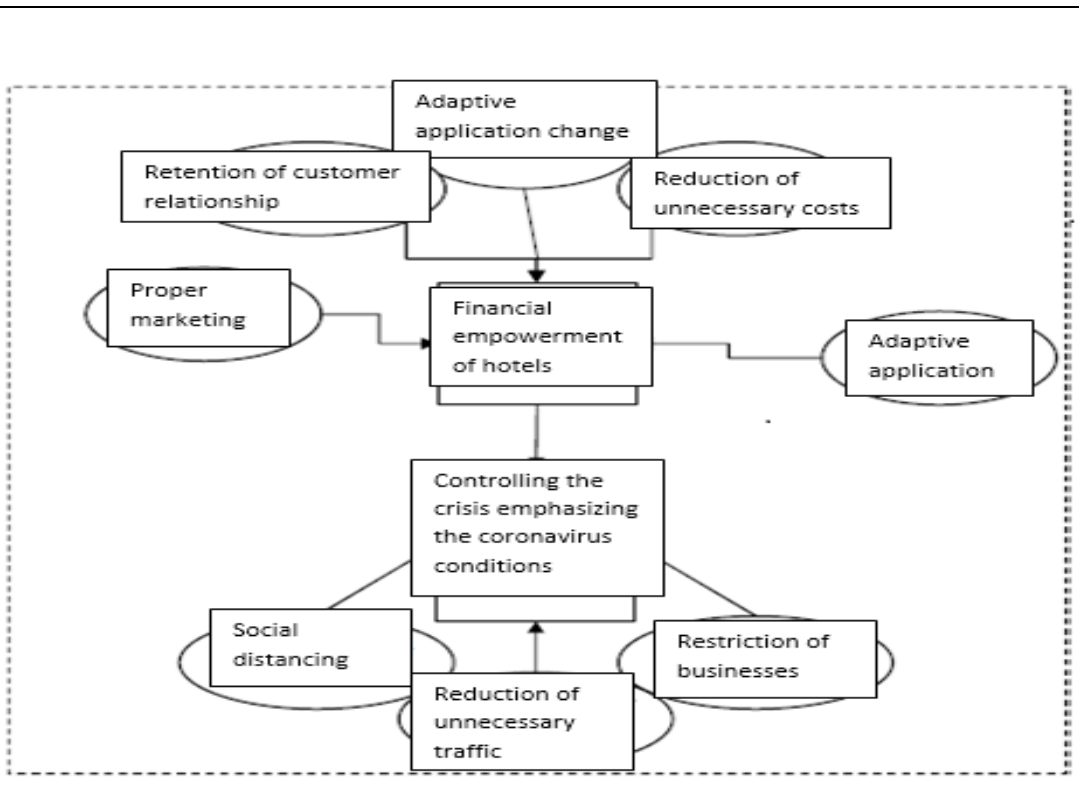
Fig. 3: The conceptual model of the research